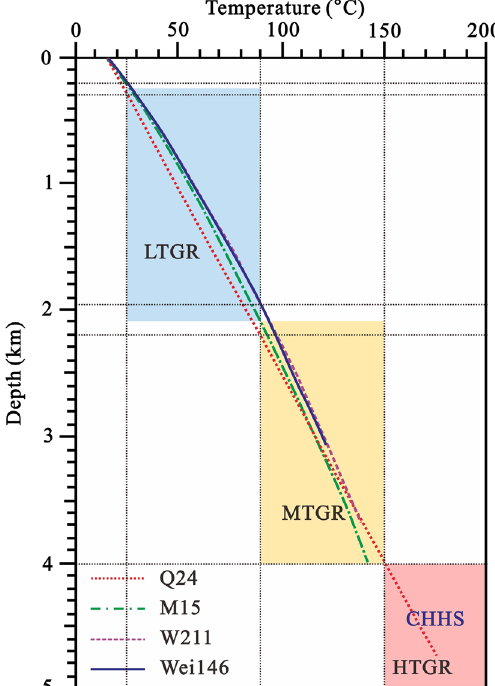
Figure 6. Temperature versus depth for typical wells in the central uplift belt. LTGH = Low-temperature geothermal resources; MTGR = Medium-temperature geothermal resources; HTGR = High-temperature geothermal resources; CHHS = Carbonate-hosted hydrothermal